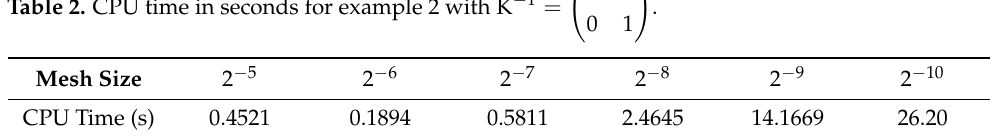
Table 2. CPU time in seconds for example 2 with K − 1